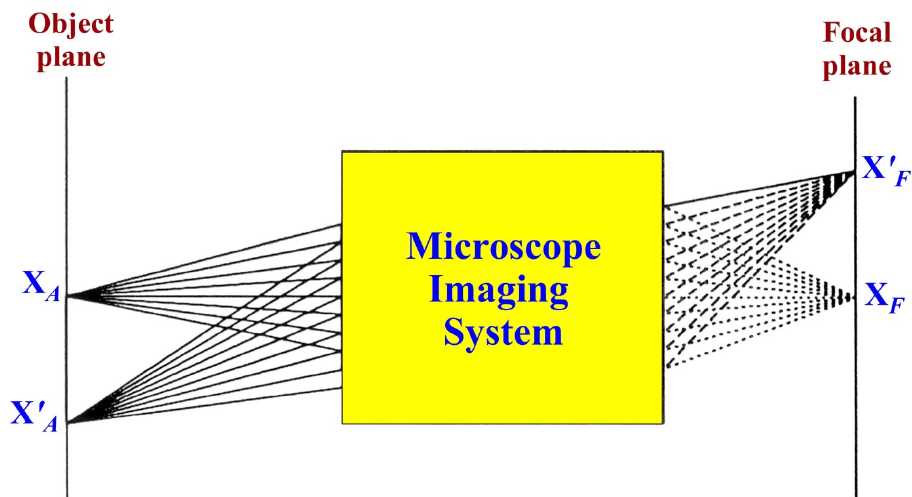
Figure 5. The model of an ideal microscope system.